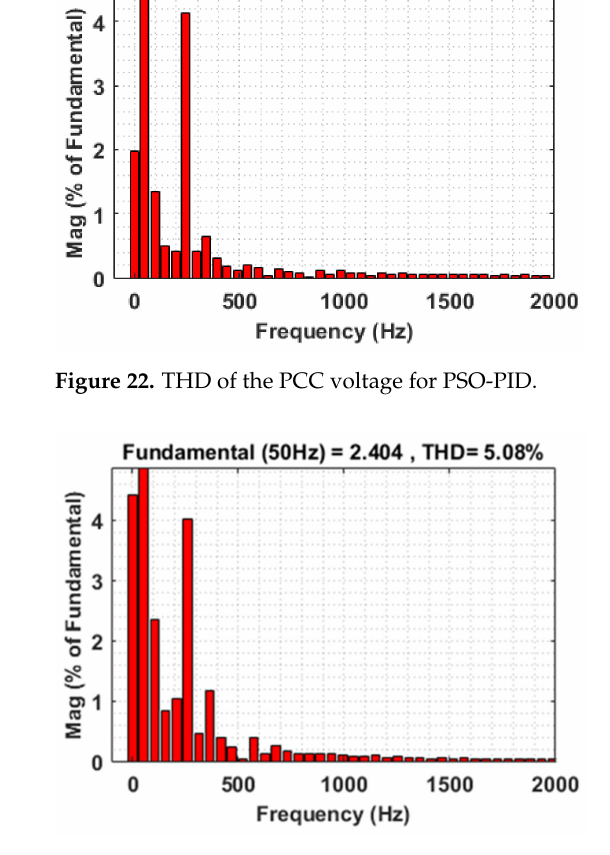
Figure 23. THD of the PCC voltage for